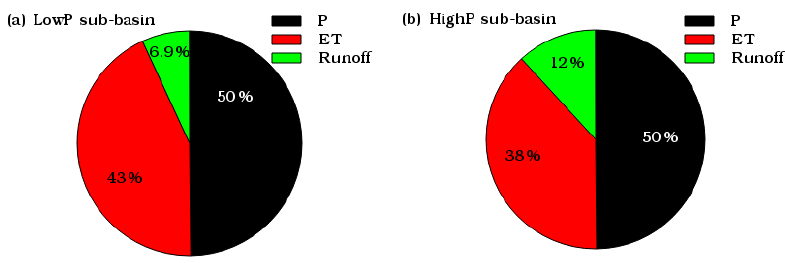
Figure 9. VIC-model-simulated (based on aspect parameterization) mean annual (2006–2008) percentage of water balance components, P (black), ET (red), and runoff (green) in the (a) LowP and (b) HighP sub-basins. The change in storage component is very small compared with the other components; hence, it is not